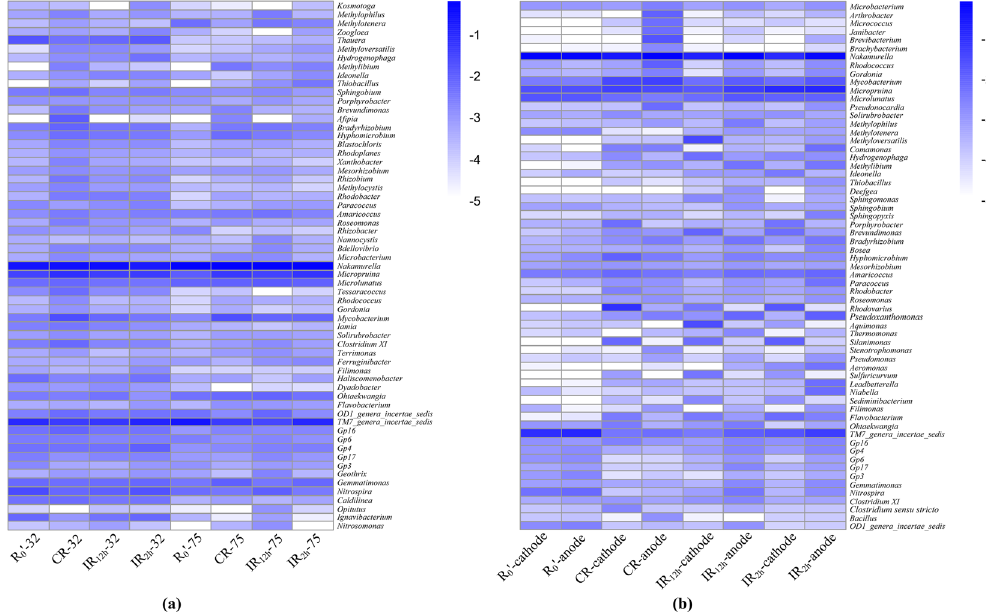
Figure 5. Heat map of genera (abundance > 0.20%) of microorganisms in SBRs under different DC application modes. ( a ) Activated sludge; ( b ) Electrode